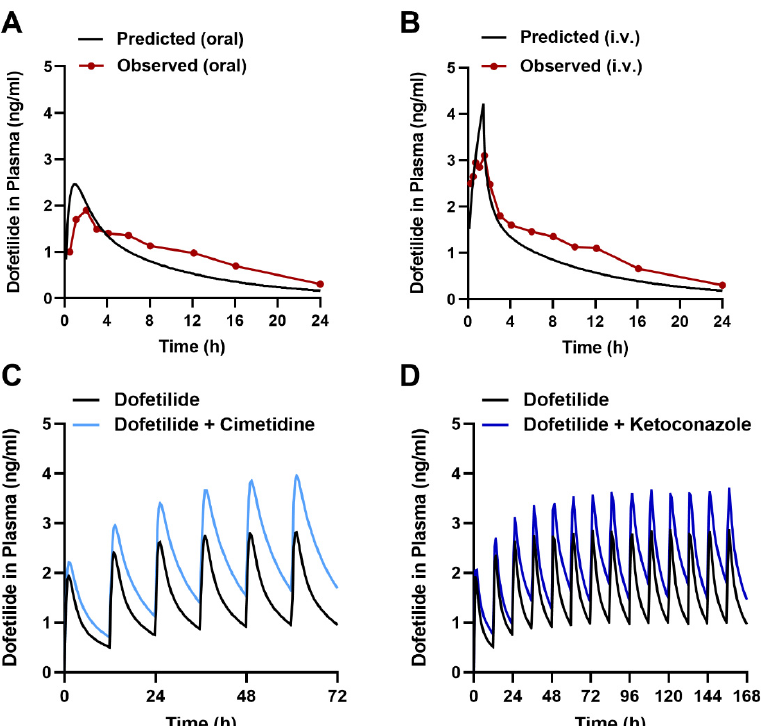
Figure 7. PBPK modeling predicts transporter-mediated interactions with dofetilide in humans. Observed and predicted plasma concentration-time profile after a single dose of 0.5 mg dofetilide oral administration ( A ), and 90-min i.v. infusion ( B ) at a single dose of 0.5 mg in adult healthy volunteers. Predicted plasma concentration-time profiles receiving multiple oral doses of dofetilide (0.5 mg, BID) with and without cimetidine (400 mg, BID) ( C ) and ketoconazole (400 mg, QD) ( D ) in healthy volunteers.